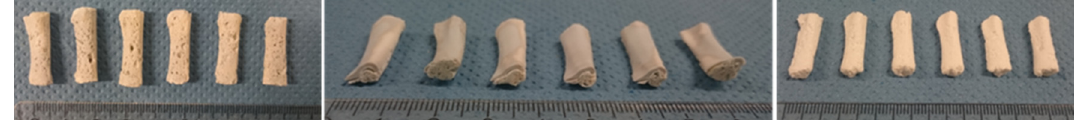
Figure 16. Comparison of the different manufactured scaffolds: left—TCP freeze foams, middle—TCP hybrid scaffold halves and right—ZrO 2 Freeze Foams.